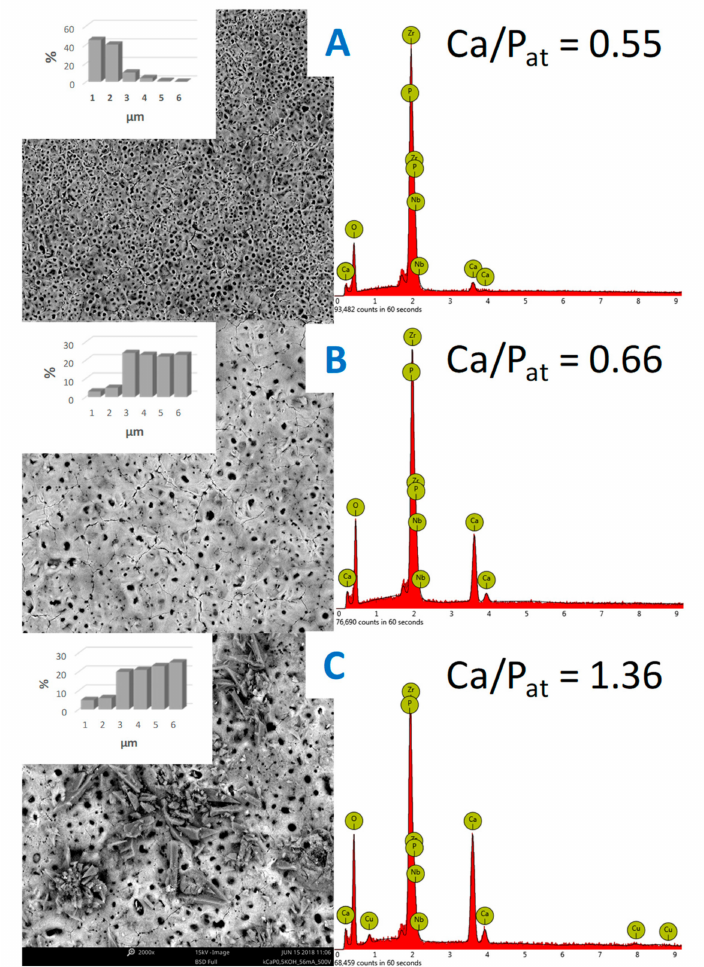
Figure 3. SEM images of the ZrNb alloy surface after PEO in a Cu-containing solution in di ff erent modes (300 V—( A ), 450 V—( B ), and 500 V—( C )) with pore distributions and EDX